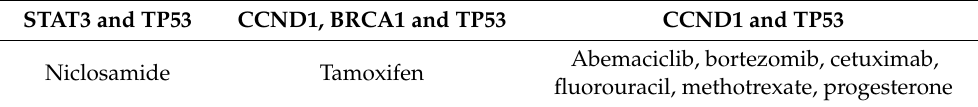
Table 10. Common remedies against hub genes and TFs. STAT3 and